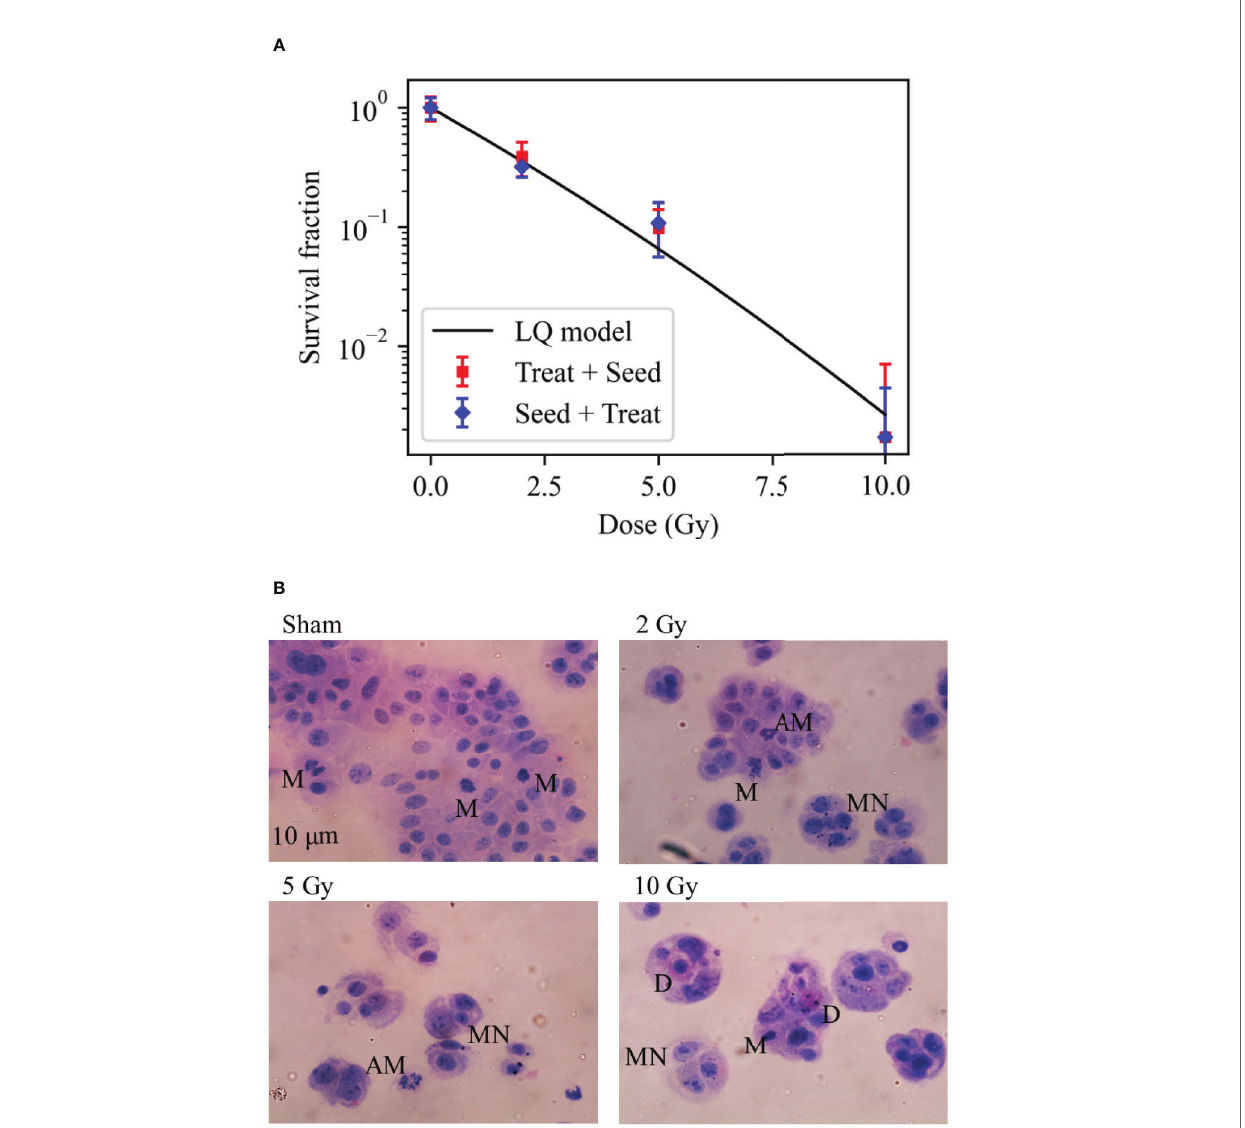
FIGURE 2 | Cell survival and cytological staining. (A) Survival fraction (SF) of Caco-2 cells exposed to 0 (sham), 2, 5 and 10 Gy of X-rays following the “ Treat + Seed ” and “ Seed + Treat ” experimental protocols (details in the text). Data are mean ± SD, obtained from ≥ 3 independent experiments. SF data are fi tted with the linear quadratic model to obtain a and b parameters, details in the text. (B) Illustrative cytological images of cells (scale bar: 10 m m) 48 h after exposure to the same X-ray doses for the “ Treat + Seed ” protocol, with evidence of micronuclei (MN), typical and atypical mitoses (M and AM) and cell death (D)